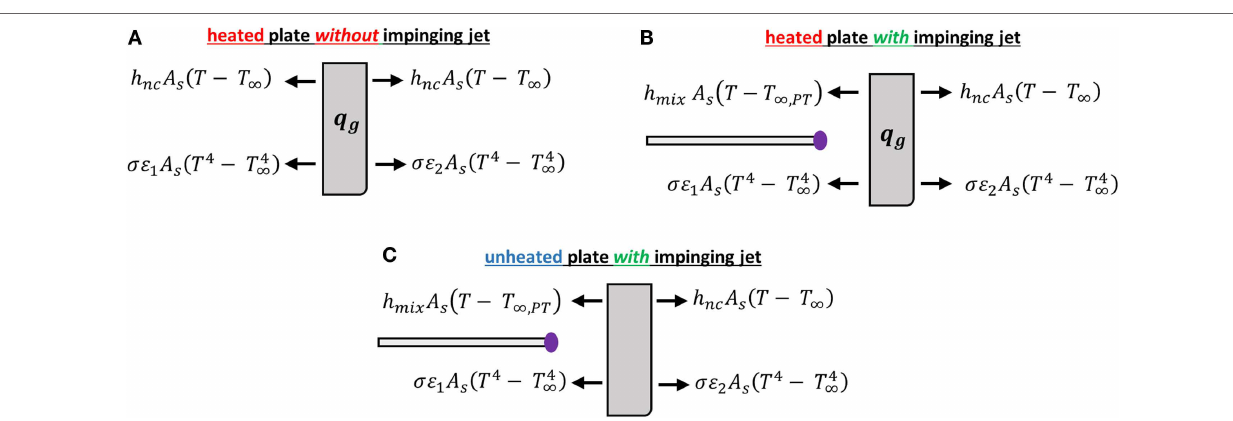
FIGURE 4 | Schematics of the three energy balances used to calculate convection coefficients where each case corresponds to the temperature contours shown in Figure 3: (A) heated plate, (B) heated plate with impinging ionic wind, and (C) unheated plate with impinging ionic wind . The arrows correspond to whether heat is being added to or removed from the